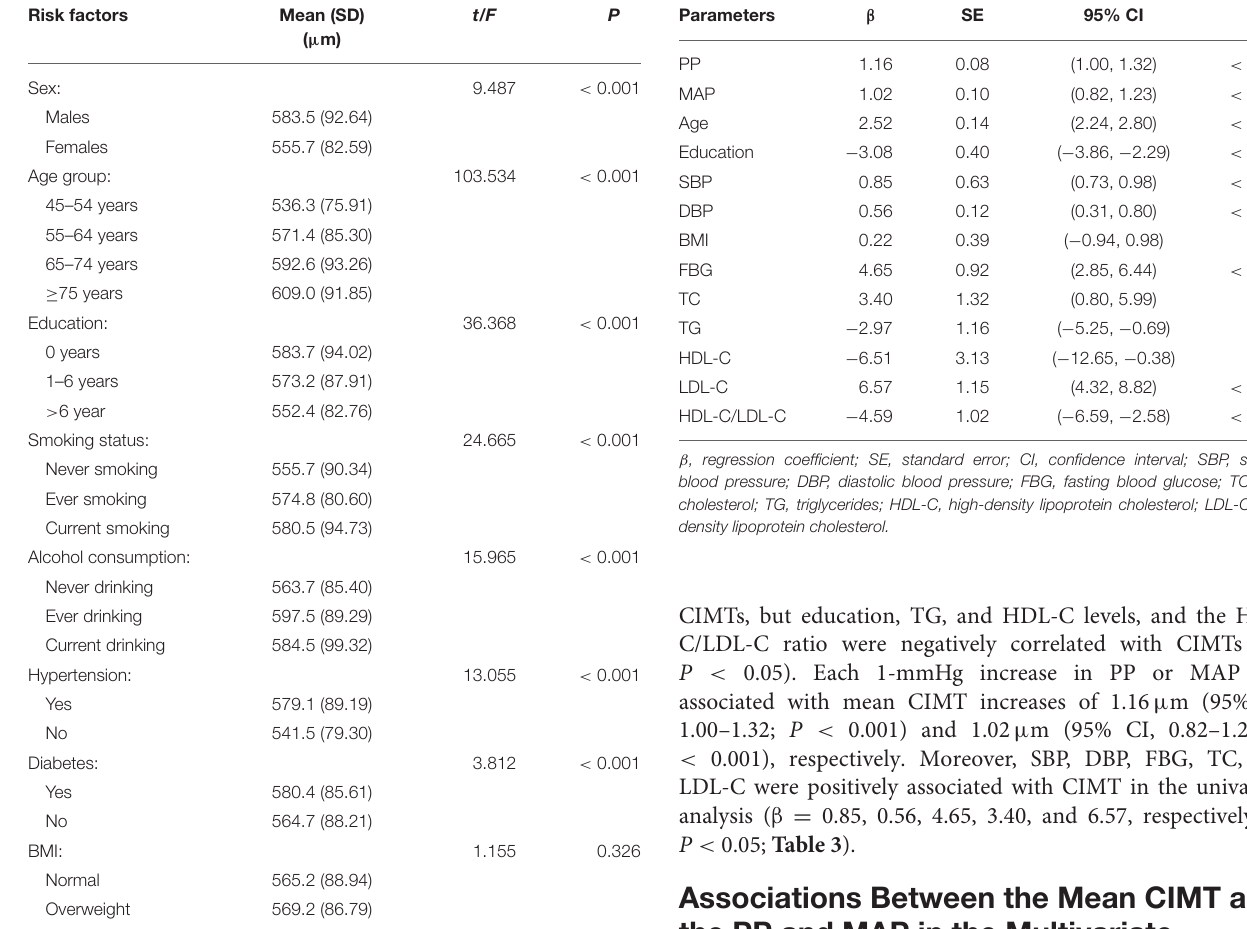
TABLE 2 | Differences in mean carotid intima-media thicknesses, according to demographic characteristics and risk factors groups. Risk factors